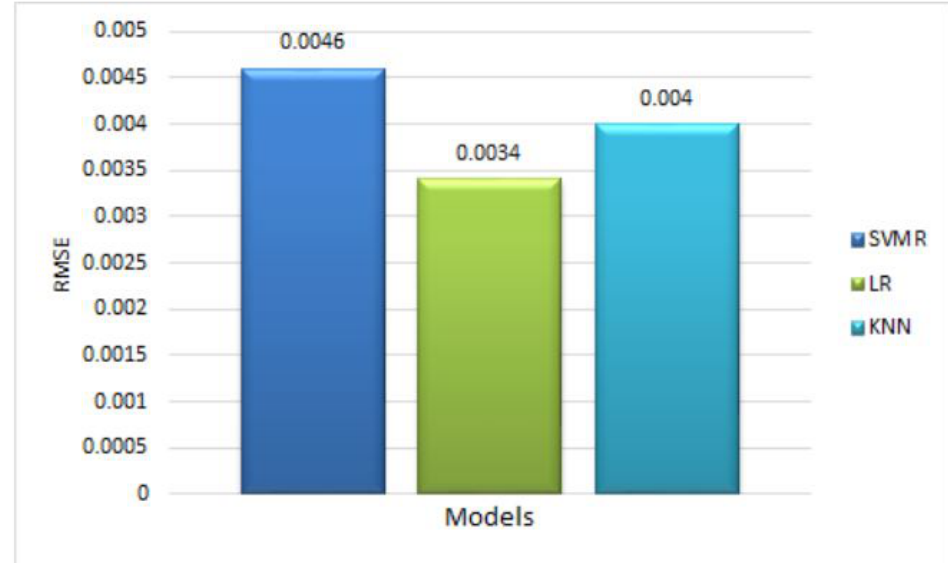
Figure 10. Different models’ RMSE value.